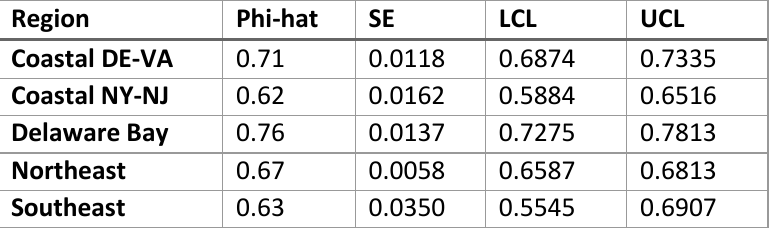
Table 5. Regional apparent annual survival rates, averaged among years 2009-2017.